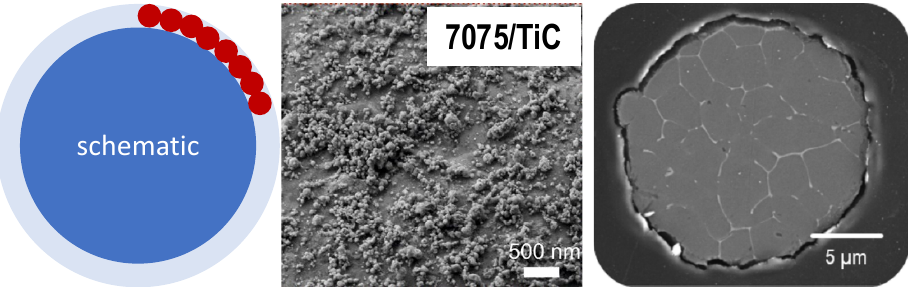
Figure 7. ( Left ): Schematic of a monolayer of nanoparticles. ( Middle ): Surface of a powder particle Figure 7. ( Left ) Schematic of a monolayer of nanoparticles. ( Middle ) Surface of a powder parti- 7075/TiC. ( Right ): Cross section of an individual powder particle 7075/TiC, rapidly solidified by cle 7075/TiC. ( Right ) Cross section of an individual powder particle 7075/TiC, rapidly solidified DFSC. by Table 4. The necessary content of nanoparticles for successful PBF-LB/M to suppress hot cracks.